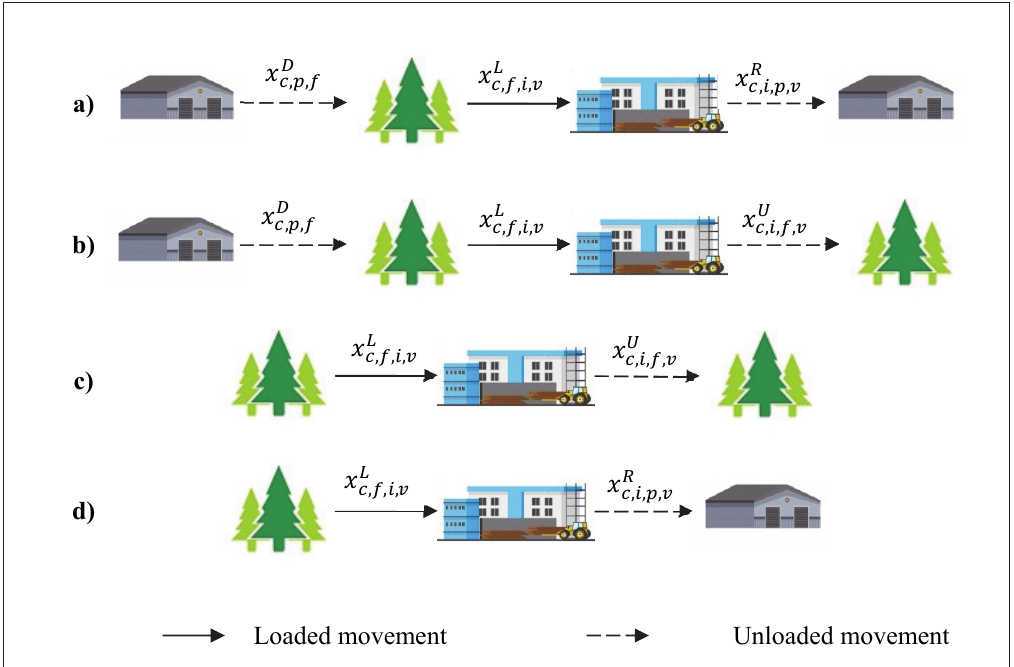
Fig. 1 . Trip composition and involved